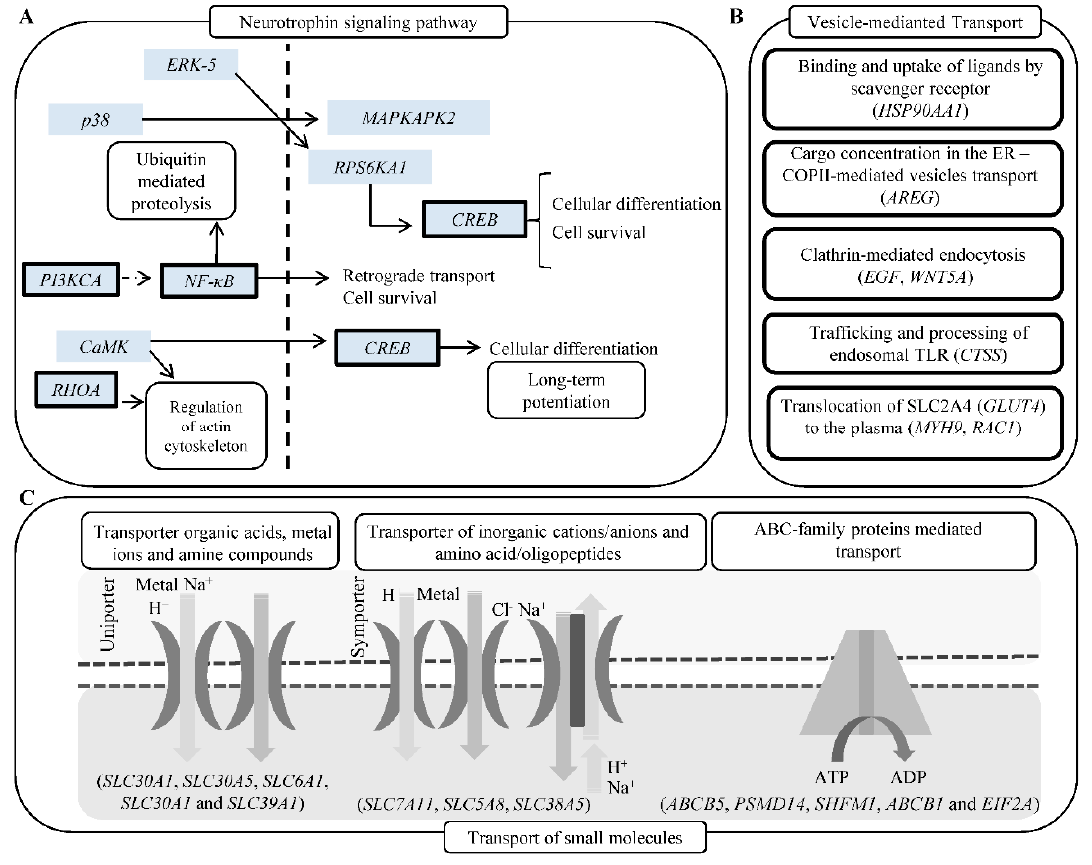
Figure 6. ( A ) Schematic depiction of genes (bold borders) up-regulated in UKF-NB-4 CDDP cells and involved in neurogenesis. ( B ) Schematic depiction of vesicles-mediated transport mechanisms with the list of genes up-regulated in UKF-NB-4 CDDP cells. ( C ) Schematic depiction of transport of small molecules, SLC-mediated transmembrane transport and ABC-family proteins mediated transport. Listed genes were identified as up-regulated in UKF-NB-4 CDDP cells. Data were analyzed by Reactome software.